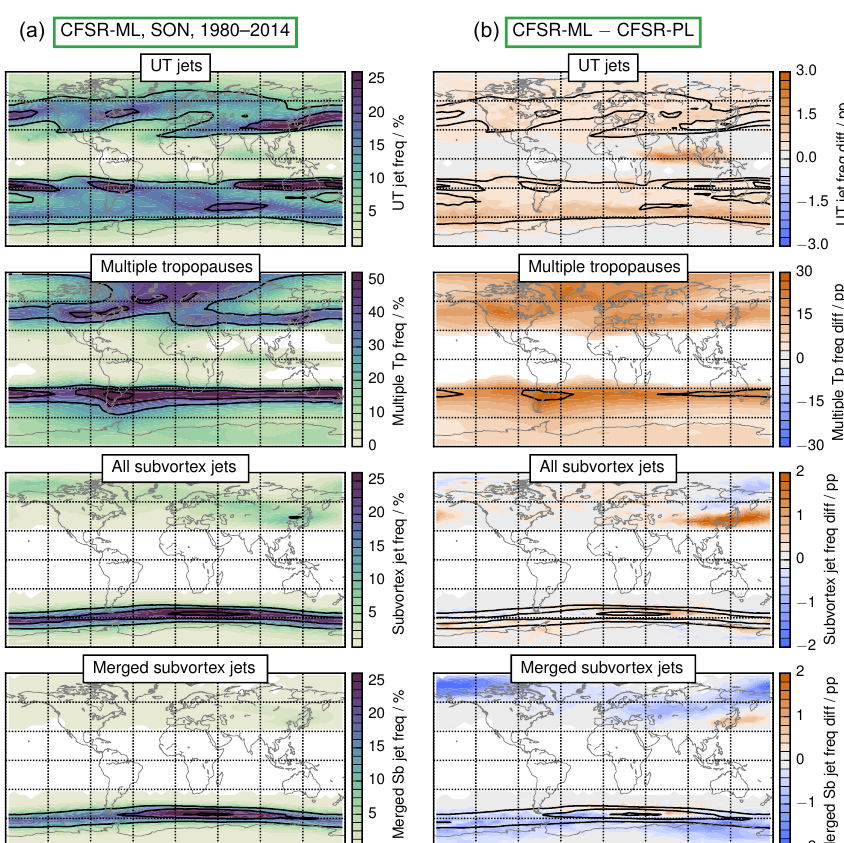
Figure 3. Seasonal maps for SON in 1980 through 2014 of CFSR frequency distributions from model-level data (a) and the difference between model and pressure-level data (b) . Layout is as in Fig. 1, except frequencies of merged subvortex (Sb) jets are shown in the fourth